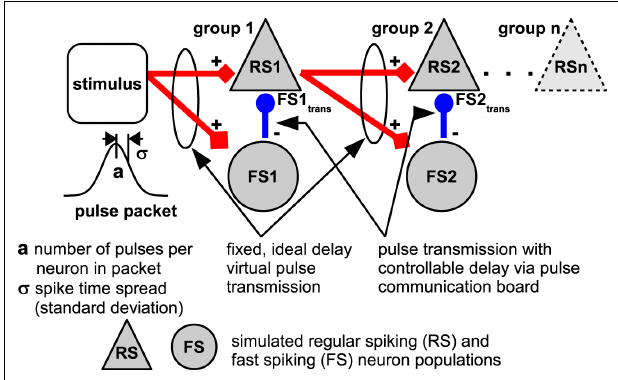
FIGURE 8 | Model of a synfire chain with feedforward inhibition employing a controllable delay, figure adapted from Kremkow et al.